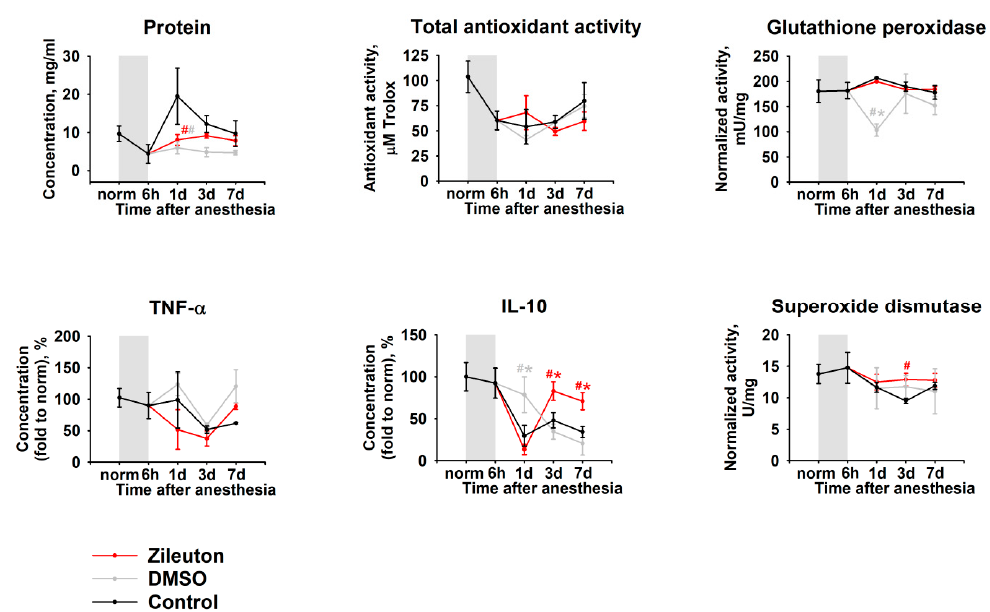
Figure 6. Dynamic changes in biochemical properties of TF in DES in the course of anti-inflammatory therapy. The animals were exposed to general anesthesia for 6 h (shown as gray box) and subsequently received instillations of the eye drops containing 50% DMSO (gray) or 50% DMSO with 0.5% zileuton (red), 1 drop 3 times daily in each eye for 7 days. TF samples were collected before (norm) and immediately after (6 h) general anesthesia as well as on 1, 3, and 7 day post-exposure. The samples were analyzed for total protein, TNF- α , IL-10, total antioxidant activity (in Trolox equivalent) and activity of glutathione peroxidase and superoxide dismutase using the respective assays. # p < 0.05 as compared to parameters of TF of the untreated animals with DES (black). * p < 0.05 as compared to parameters of TF of the animals from the DMSO or zileuton